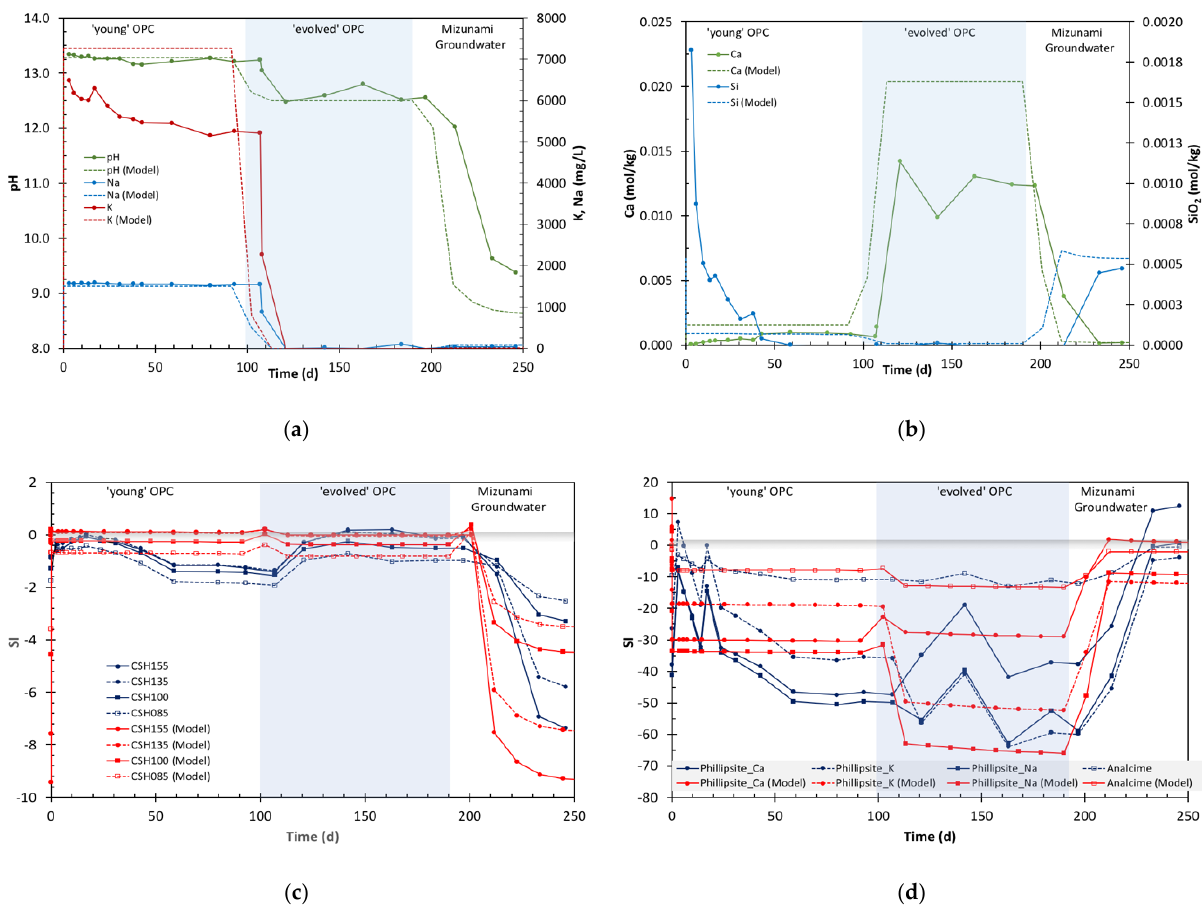
Figure 10. Summary of the model predictions compared with the experiment data: ( a ) pH, [Na], and [K]; ( b ) [Ca] and [SiO 2 ]; ( c ) selected C-S-H saturation indices; ( d ) zeolite saturation indices.